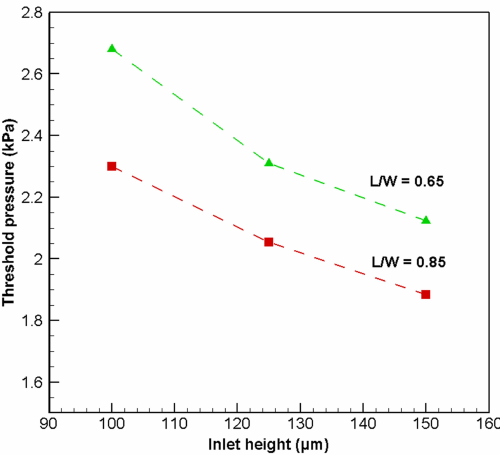
Figure 13. Opening threshold pressure of microvalve for various inlet region heights for L/W = 0.65 and 0.85